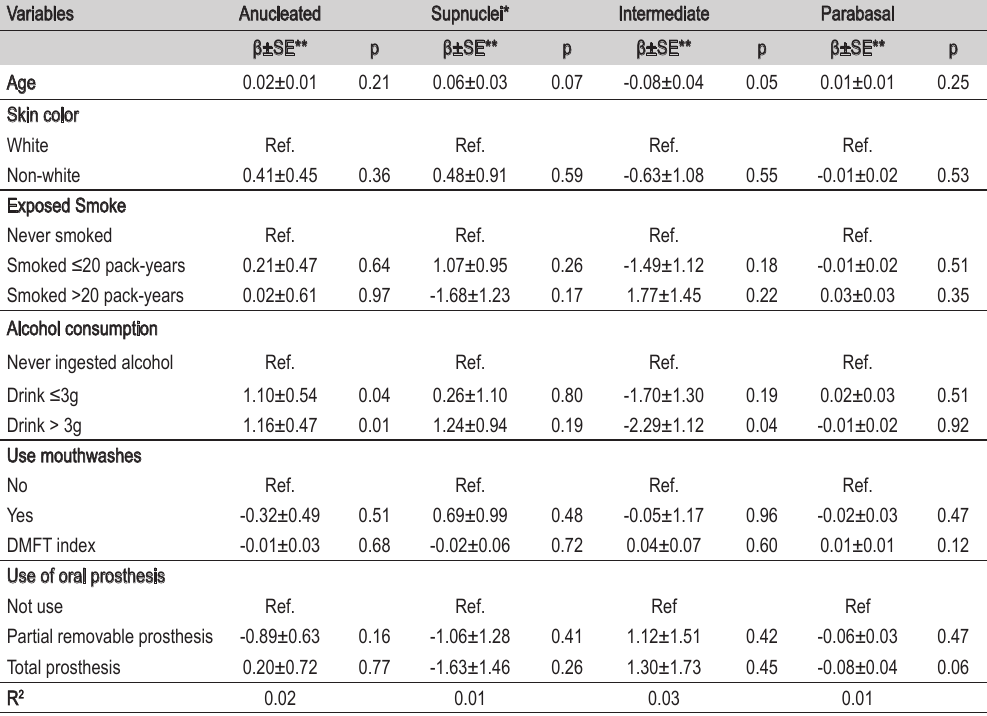
Table 5 - Multivariate linear regression model of the association between the percentage of cells on the floor of the mouth and the independent variables.